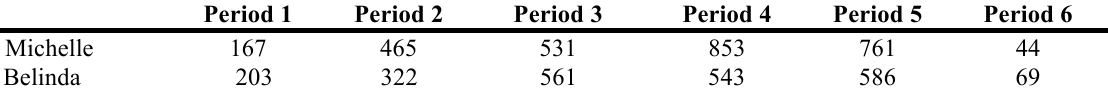
Michelle’s and Belinda’s WTC from Period 1 through 6; r